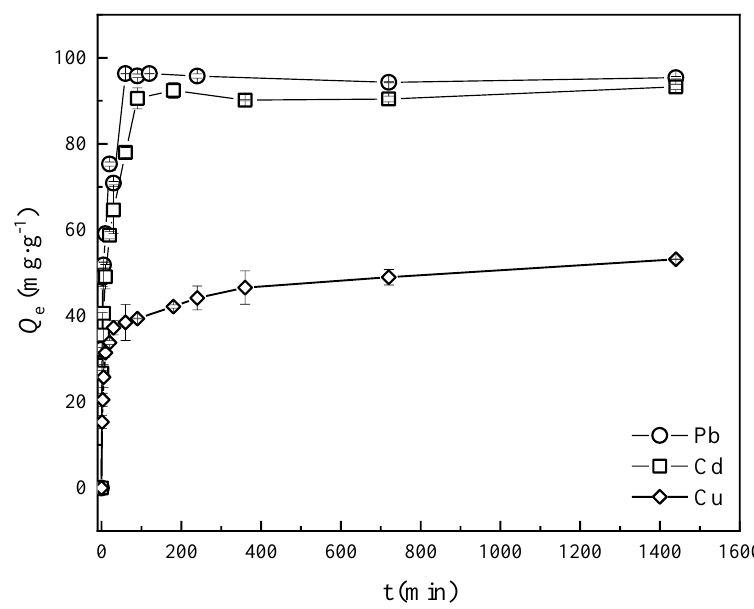
Figure 4. Adsorption kinetics curve of Cd 2+ , Pb 2+ and Cu 2+ onto MSBC-2 and SBC. As for Pb 2+ , Cd 2+ and Cu 2+ , the correlation coefficients ( R 2 ) of the intraparticle model